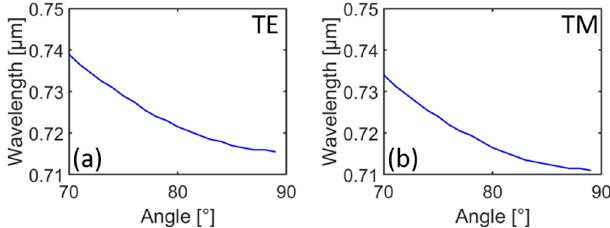
Figure 9. Peak absorption wavelength of the device for varying incidence angle (70–90 ◦ ) under both TE and TM polarizations. The device period p, the waveguide Ta 2 O 5 thickness t Ta2O5 , and PMMA pillars height t PMMA are fixed at 600 nm, 150 nm, and 600 nm, respectively.